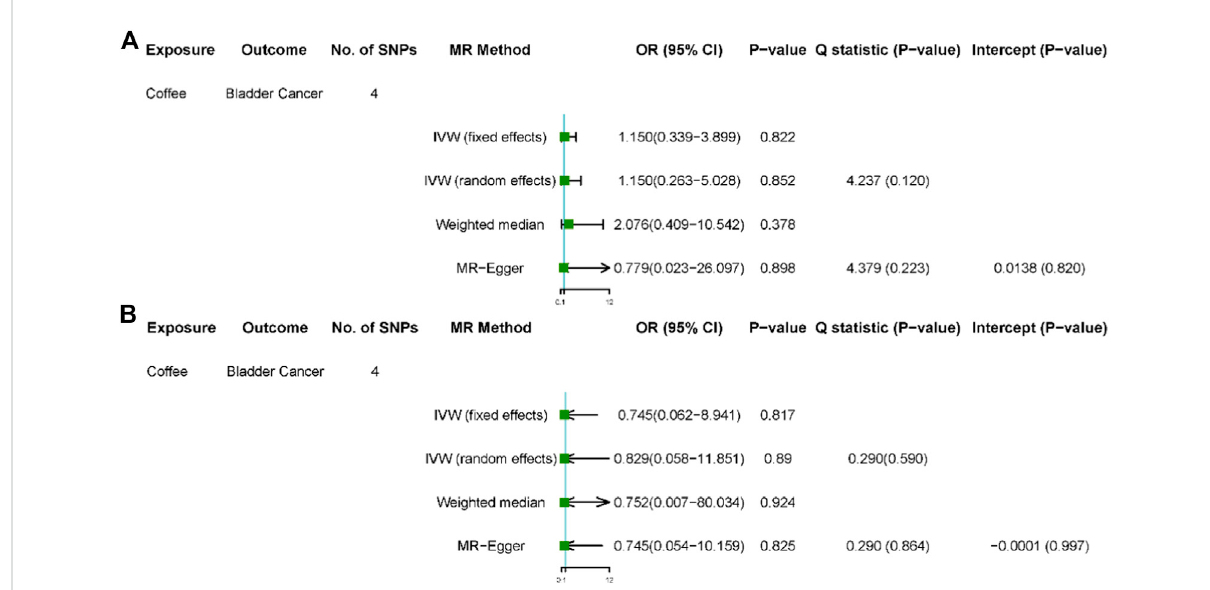
FIGURE 2 Results ofsensitivityanalyses.Associationofgenetically predicted coffeeconsumptionwithbladdercancerriskintheUnitedKingdomBiobank (A) and FinnGen consortium (B) . OR, odds ratio; CI, con fi dence interval; SNP, single-nucleotide polymorphism.